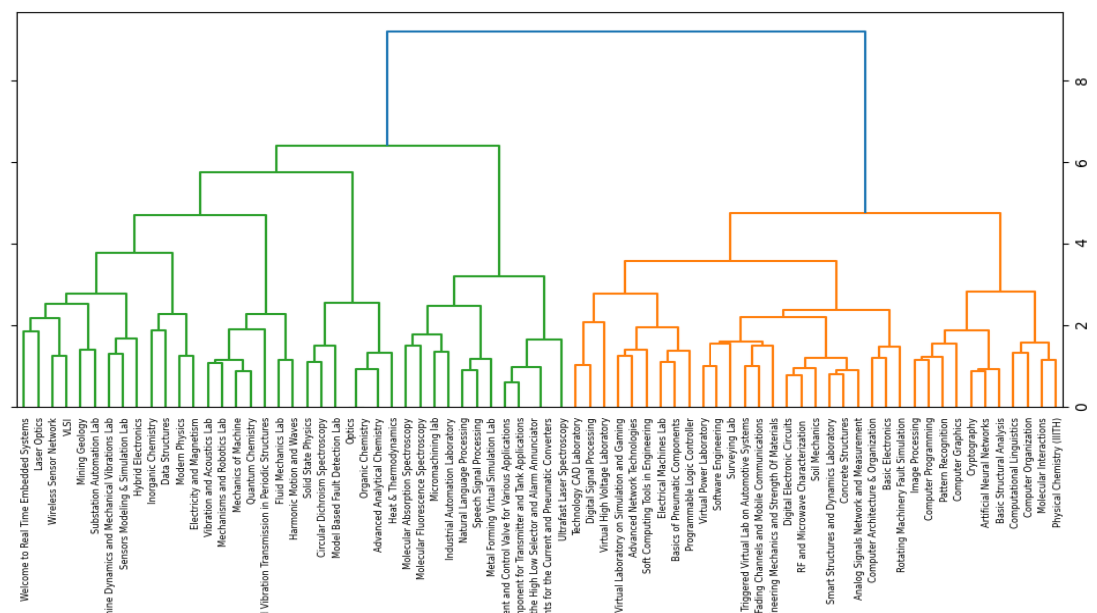
Figure 4. Optimal number of clusters for HAC algorithm using dendrogram.